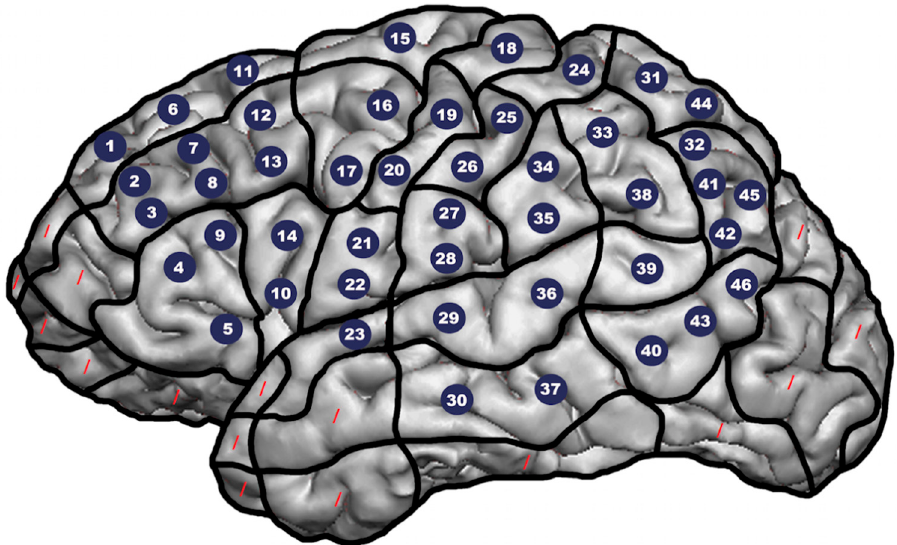
Figure 1. Cortical parcellation system (CPS). The tumor-a ff ected left hemisphere (LH) was mapped by navigated transcranial magnetic stimulation (nTMS) with respect to 46 target points that were placed in relation to the CPS (reduced numbers of target points were accepted in patients with large tumor masses, which hampered placement of the total amount of 46 target points). The points were stimulated six times in total each, with a stimulation intensity of 100% of the individual resting motor threshold and a stimulation frequency of 5 Hz / 5 pulses. Numbers in circles schematically represent the stimulation targets on a standardized brain template, red dashes mark regions that were not subject to